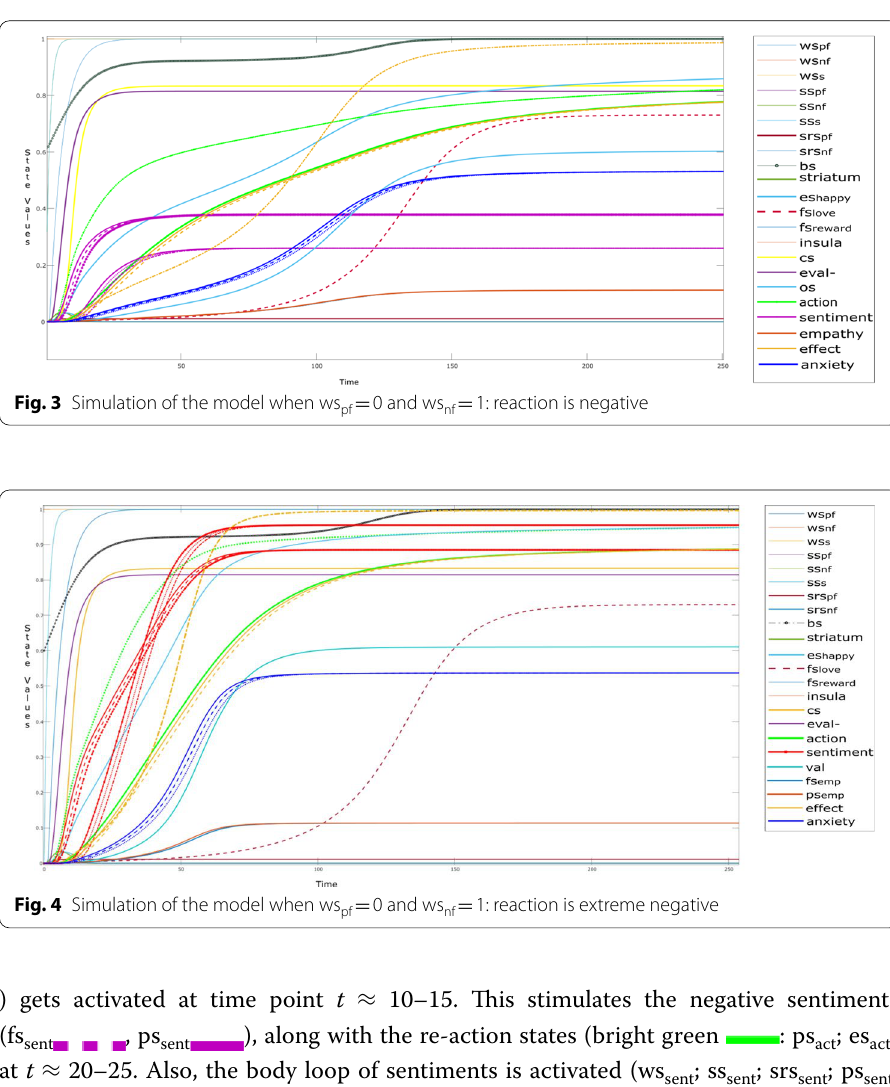
Fig. 4 Simulation of the model when ws pf